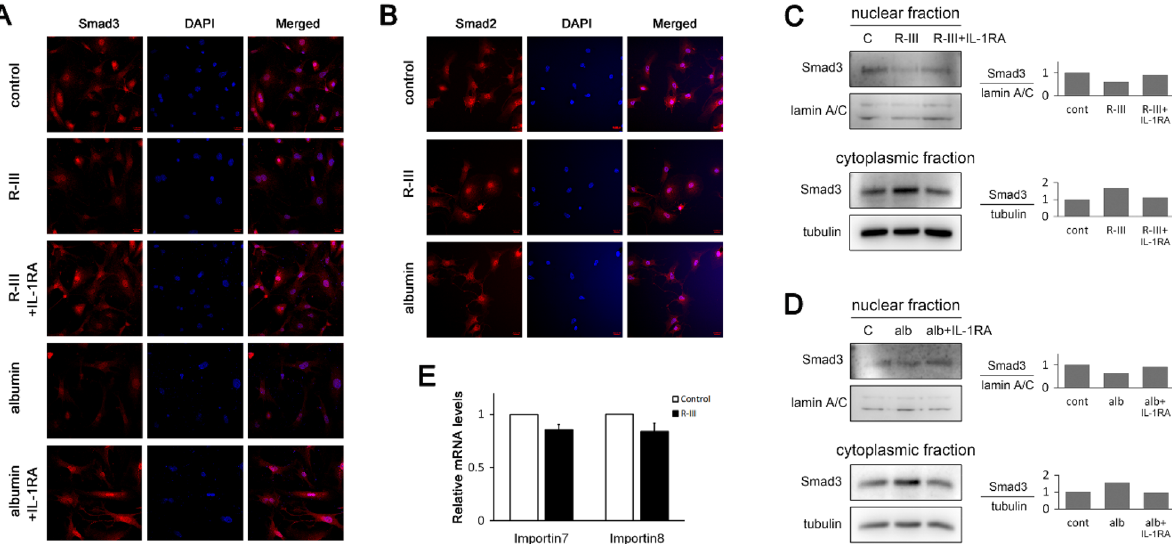
Figure 4. R-III treatment and albumin expression inhibit the nuclear translocation of Smad3 in hepatic stellate cells. ( A – D ) Hepatic stellate cells after passage 1 (HSCs-P1) were treated with R-III (0.25 μM) or transfected with an albumin expression vector in the presence or absence of interleukin (IL)-1RA and then analyzed by immunofluorescence using antibodies against Smad3 ( A ) or Smad2 ( B ). Nuclear and cytoplasmic fractions were prepared from the R-III-treated ( C ) and albumin-transfected cells ( D ) and subjected to western blotting using anti-Smad3 antibody. Bar graph represents the average of two independent experiments. Full-length blots are presented in Supplementary Fig. S4. ( E ) HSCs-P1 were treated with R-III, and the importin 7 and importin 8 expression levels were then analyzed by real-time linker region and inhibit its nuclear translocation 32,33 . Therefore, we carried out several experiments to elucidate the mechanism through which albumin/R-III inhibits the nuclear import of Smad3 IL-1β-dependently. Western blot analysis revealed that albumin/R-III in HSCs-P1 led to an increased phosphorylation of TAK at Ser412, which is required for TAK1-mediated IL-1R signaling 34 , whereas phosphorylation at the TAK1 autophospho- rylation sites T184 and T187 was not significantly changed (Fig. 5A, Supplementary Fig. S2). Albumin/R-III also enhanced the level of p-JNK, but not that of p-p38, and increased the phosphorylation of Smad3 linker region at S208. However, the C-terminal phosphorylation of Smad3 (S423, S425) was not affected. Importantly, these R-III effects on Smad3, JNK, and α-SMA were abrogated by IL-1RA (Fig. 5B), suggesting that albumin/R-III- mediated IL-1β signaling induces the phosphorylation of the Smad3 linker region. When HSCs-P1 were treated with R-III in the presence of the inhibitor for p38 (SB203580), JNK (SP600125), or TAK1 ((5Z)-7-oxozeaenol), the phosphorylation of the Smad3 linker region was reduced by (5Z)-7-oxozeaenol and SP600125 (Fig. 5C). Lastly, to confirm the functional significance of Smad3 linker phosphorylation, we transfected HSCs-P1 with the expression vectors for wild-type or mutant Smad3 (S204A, S208A, S213A; in which three linker phospho- rylation sites were substituted for alanine). The effects of R-III on the subcellular localization of Smad3 and the expression of α-SMA and collagen type I were not observed in the mutant Smad3-expressing HSCs (Fig. 6A–C). These findings suggest that the albumin/R-III-induced phosphorylation of the Smad3 linker region may affect the subcellular localization of the protein and consequently inhibit TGF-β-Smad3 signaling.